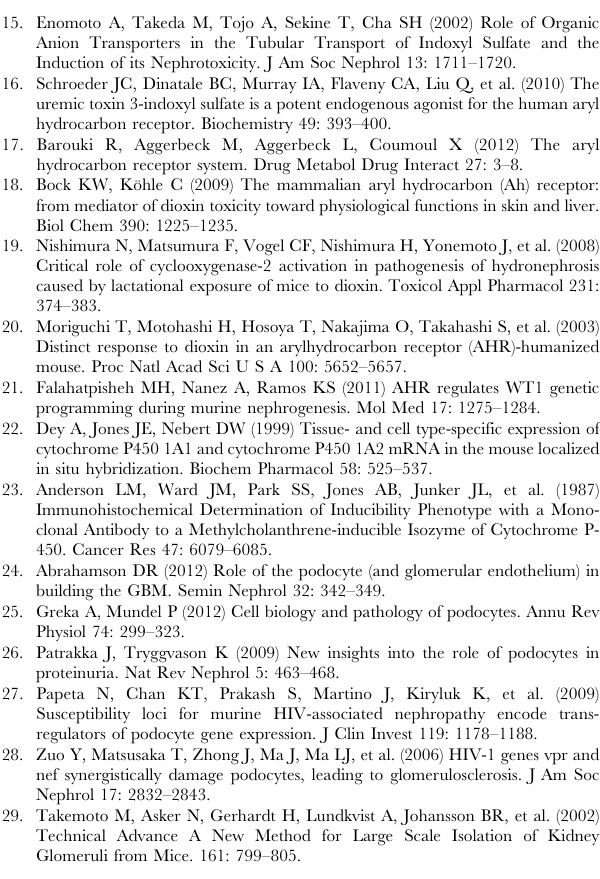
Table S1 Antibodies used in this study. Table S2 Primers used in this